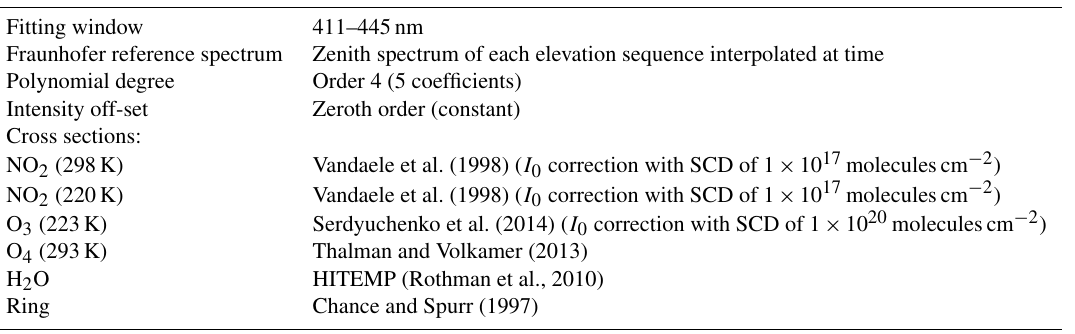
Figure 2. (a) Image of the area around the MAX-DOAS station (GIGCAS) in the Guangzhou megacity, China. The red lines indicate the two main azimuth viewing angles of the MAX-DOAS instrument (115 and 315 ◦ ). The rectangles outline the GOME-2A, GOME-2B and OMI pixel sizes and positions on 18 September, 3 June and 7 April 2015, respectively. The circles outline areas of different radii around GIGCAS. The image is a courtesy of the Google Earth NASA images. (b) Rose diagram showing the frequency of tropospheric NO 2 columns observed at the different azimuth viewing angles as a percentage of the total number of measurements performed in each direction separately. Table 1. Main features of the DOAS